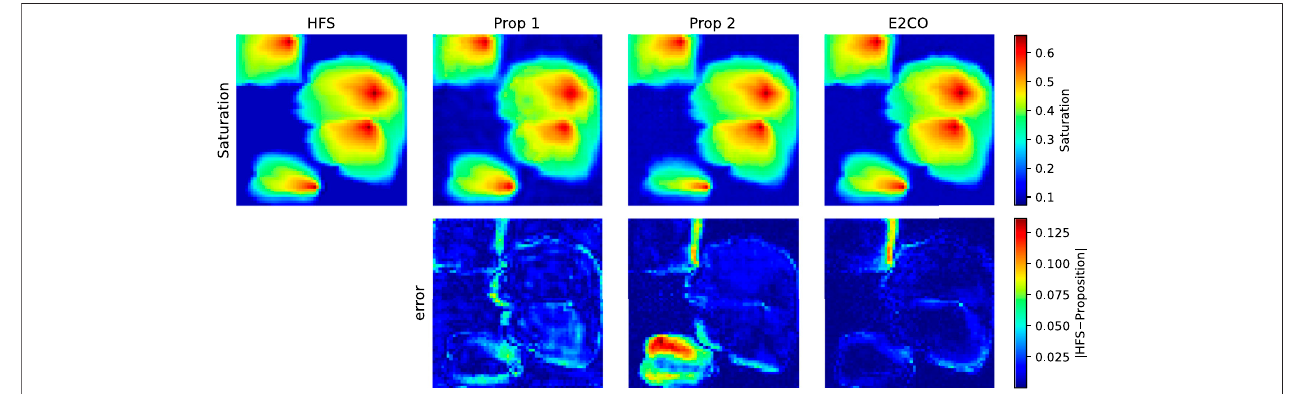
FIGURE 21 | Water saturation map for the last predicted time step of validation sample